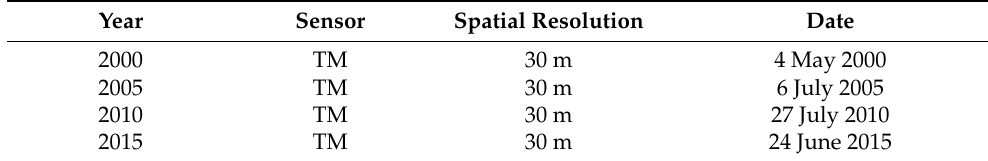
Table 1. Parameters of Landsat TM images.